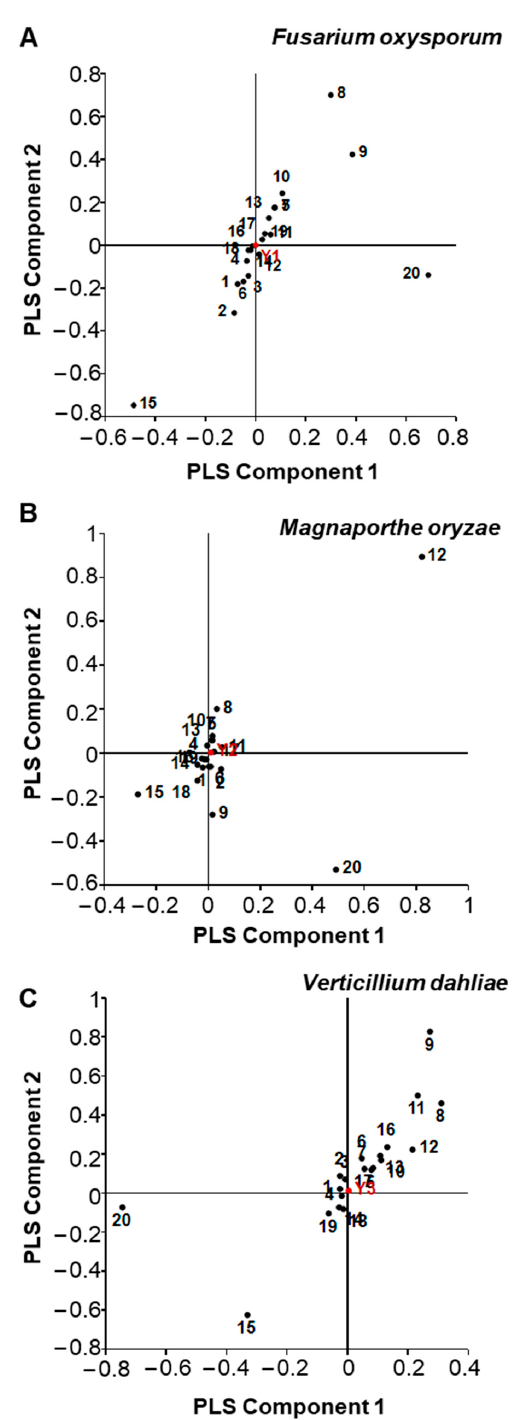
Figure 5. Partial least squares (PLS) loadings for colony diameter (Y-variables) of Fusarium oxysporum ( A ), Magnaporthe oryzae ( B ), Verticillium dahliae ( C ) and the content of terpenoid compounds (X-variables) in 12 cultivars of C. morifolium . Number 1–20 refer to the codes of terpenoid compounds in Table